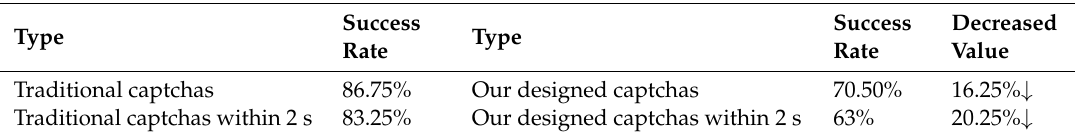
Table 2. The successfully recognized rates with human naked eyes of the traditional captchas and our